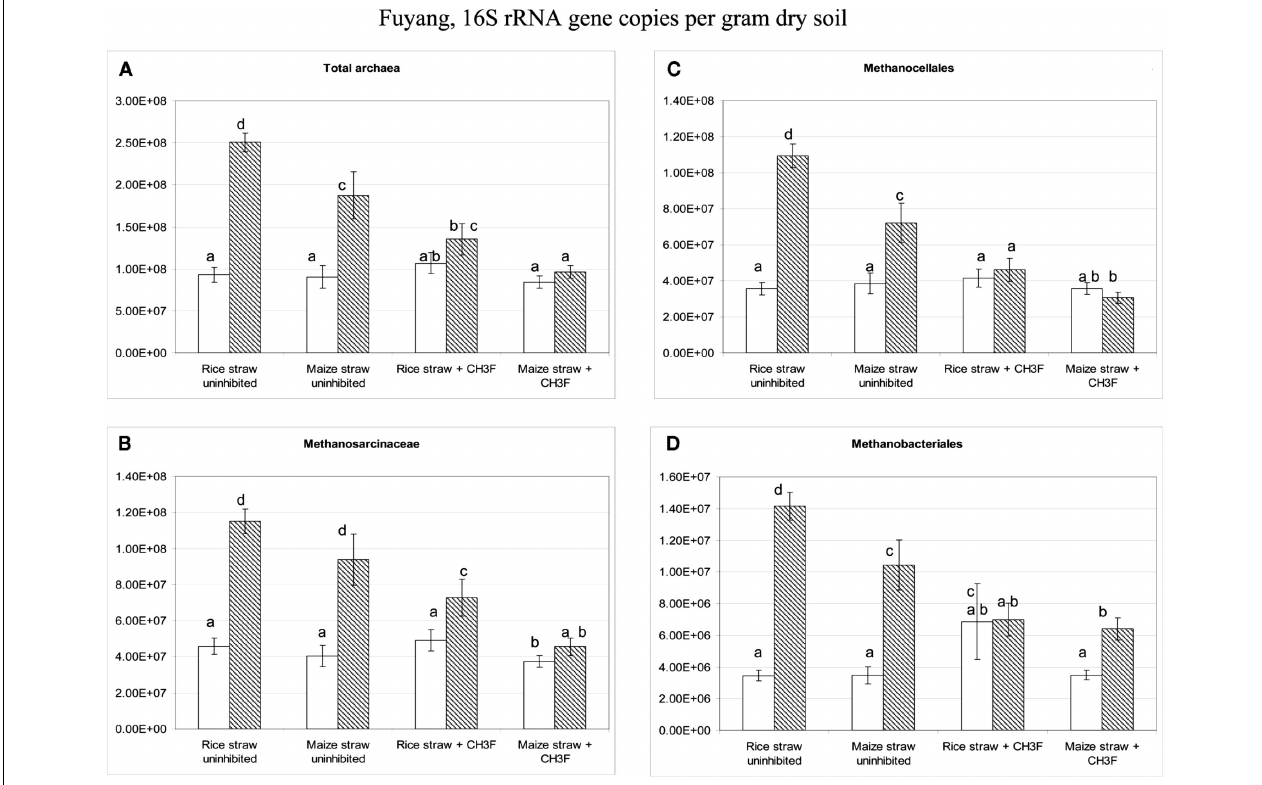
Fuyang soil with either rice straw or maize straw in the presence and absence of CH 3 F; mean ± SE, n = 3 . Different letters indicate significant ( p < 0.05) differences between columns. Beginning and end of incubation are as in Figure 1